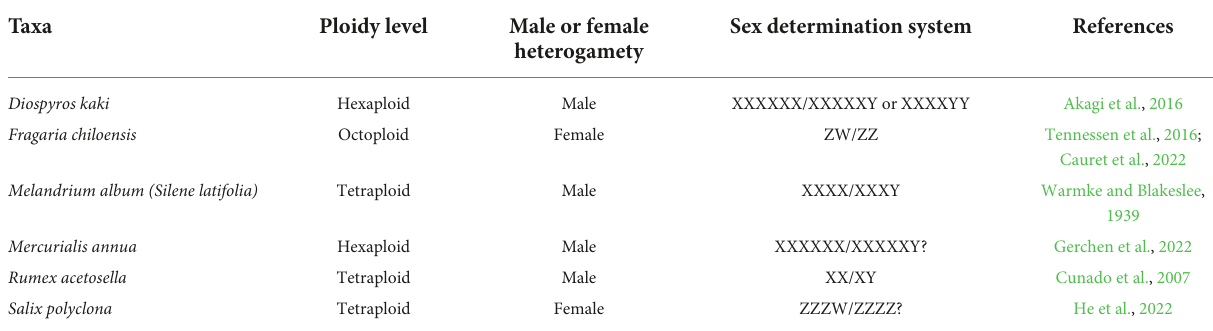
TABLE 1 Examples of polyploid plants with known sex determination